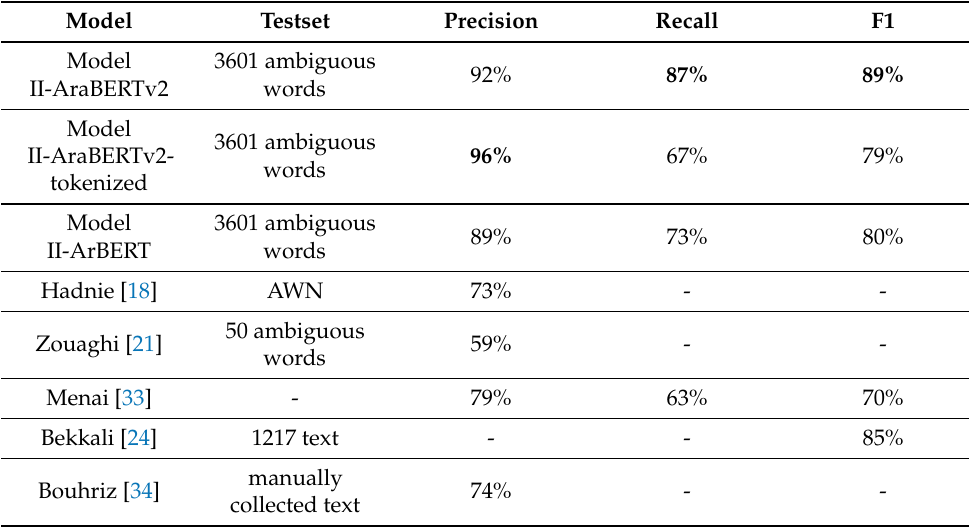
Table 10. Model II versus other knowledge-based